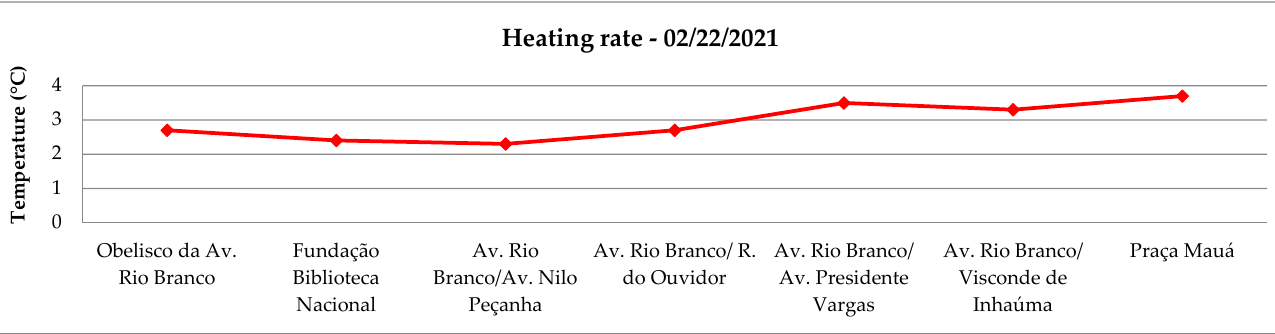
Figure 12. Rio de Janeiro—heating rate of sampling points on 22 February (Monday).